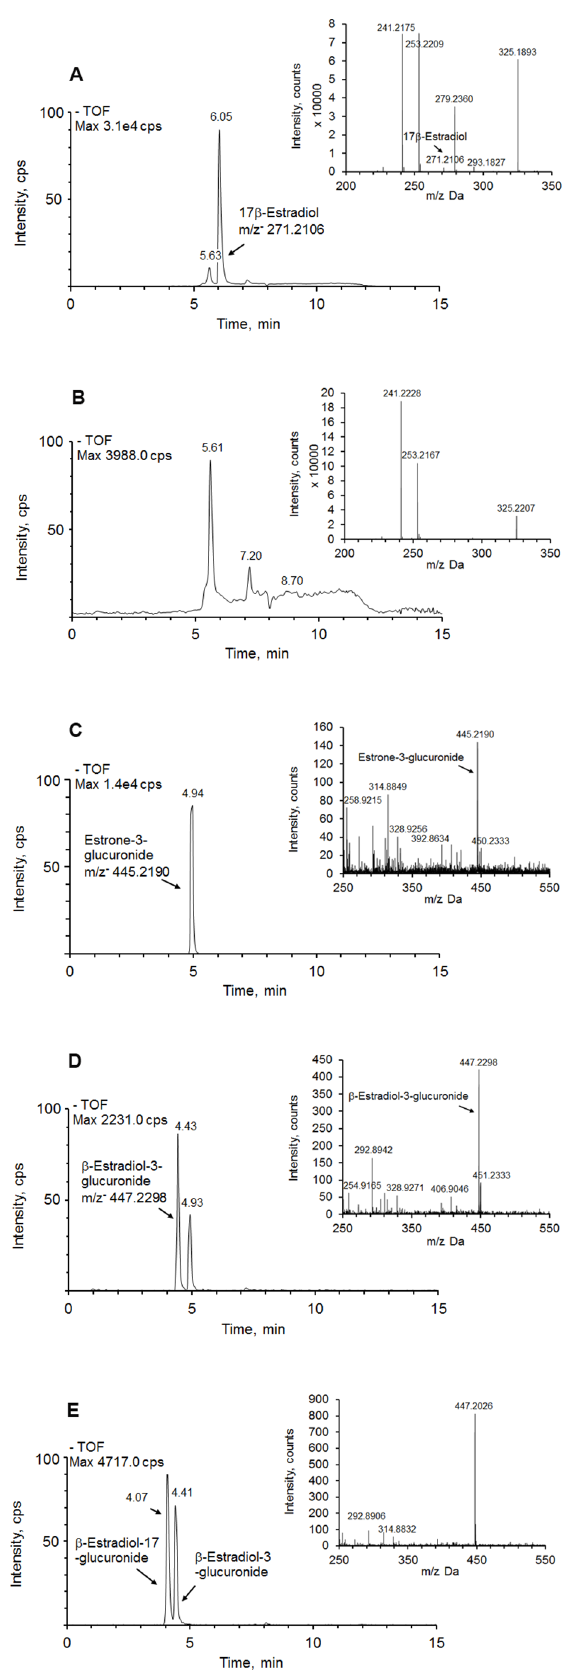
Figure 2. Ion chromatograms and mass spectra (inset) of 17 b - estradiol and its metabolites. ( A ) 17 b -estradiol in the medium in absence of isolated hepatocytes; ( B ) 17 b -estradiol in the medium in the presence of isolated hepatocytes. No 17 b -estradiol was found after 6 h of cell culture; ( C ) identified 17 b -estradiol metabolite estrone-3- glucuronide (m/z 2 =445.2190). The samples were analyzed in ESI– ionization mode; ( D ) identified 17 b -estradiol metabolite b -estradiol-3- glucuronide (m/z 2 =447.2298) in ESI– ionization mode; ( E ) a mixture of authentic standards b -estradiol-17-glucuronide and b -estradiol-3-glu-